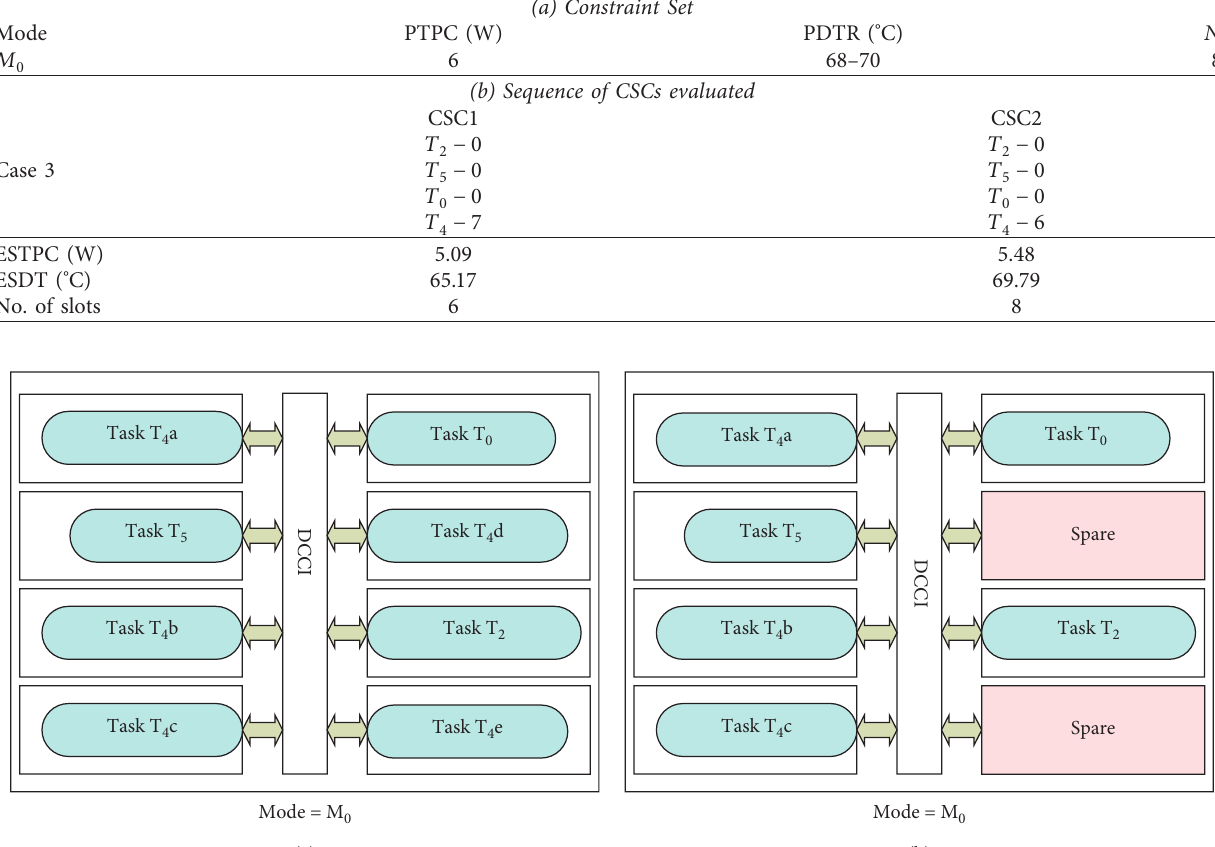
Table 7: Constraint Set and CSCs evaluated for case 3.